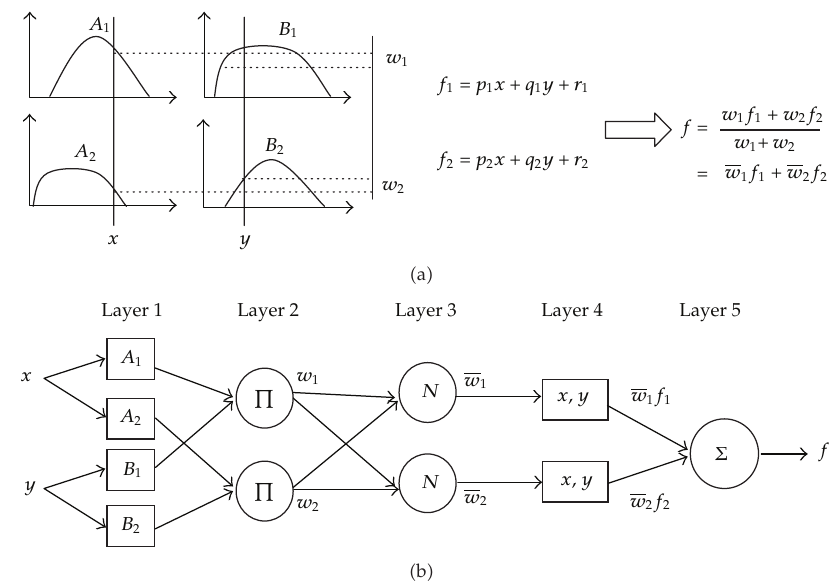
Figure 5: Adaptive neurofuzzy inference systems (cid:4) 13 (cid:5)